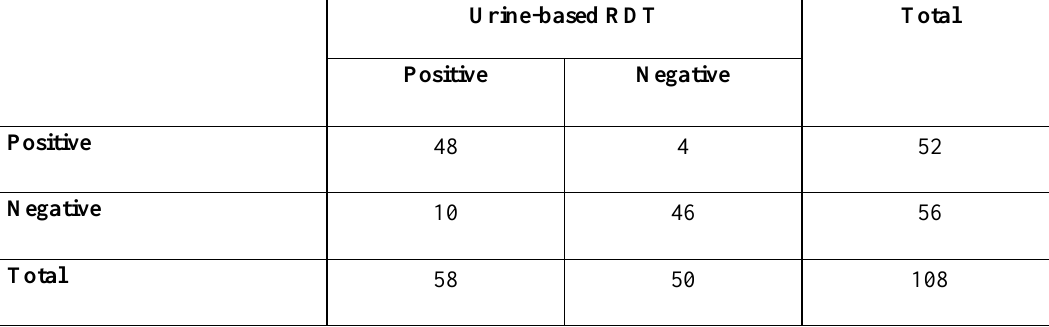
Table 3. Urine-based RDT results regarding blood smear microscopy for Plasmodium falciparum malaria (BFFPfM) as a reference